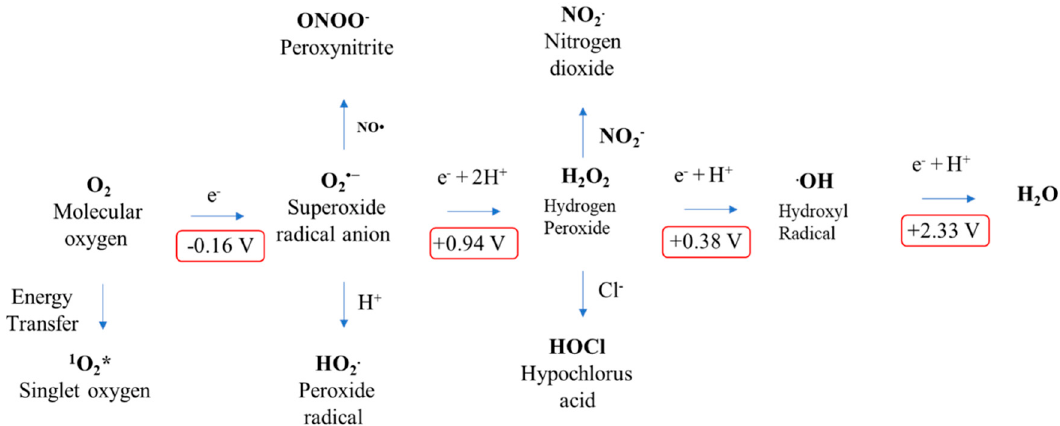
Figure 3. Standard reduction potentials of ROS formation via energy or electron transfer reactions of molecular oxygen.